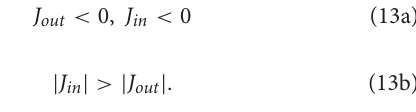
5 via a jump = 1, J I 1.5, m 0 0.2, f E 0.5, K 0.08 N , and θ 0.7. = = = = = =